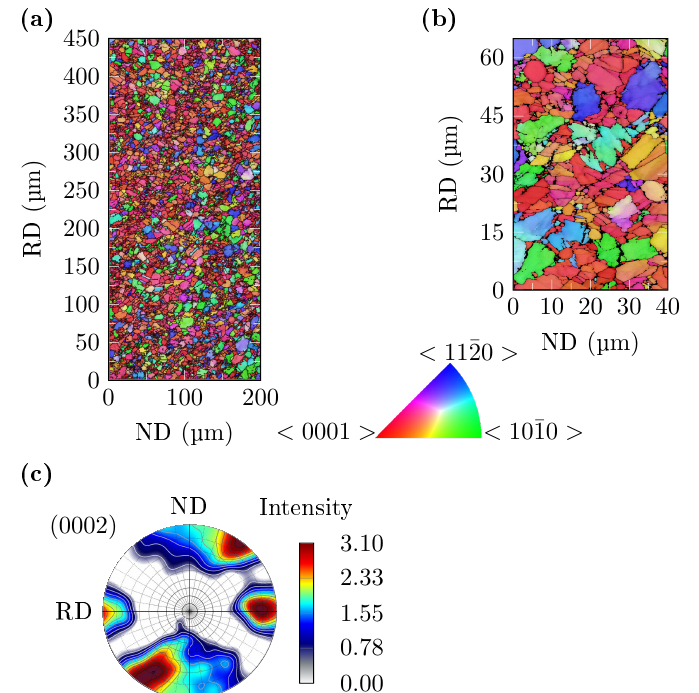
Figure 10. EBSD measurements of the structural component specimen BS9-008 made of AZ31B after cyclic loading: ( a ) EBSD orientation map of the specimen BS9-008 with scanning step size of 1µm with reference direction in ND; ( b ) EBSD orientation map of the specimen BS9-008 with scanning step size of 0.115µm with visible serrated grain boundaries and reference direction in ND; ( c ) ( 0002 ) pole figure of the specimen BS9-008 with view in